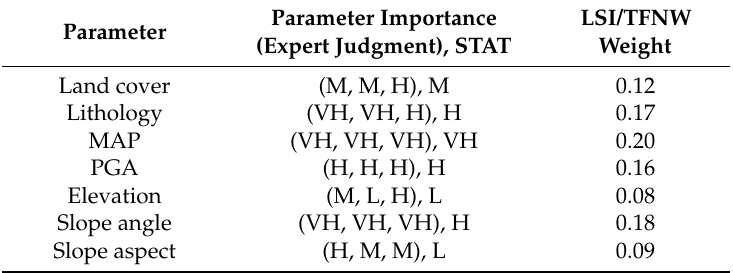
Table 2. Weight values for each factor according to the integration LSI/TFNW method.